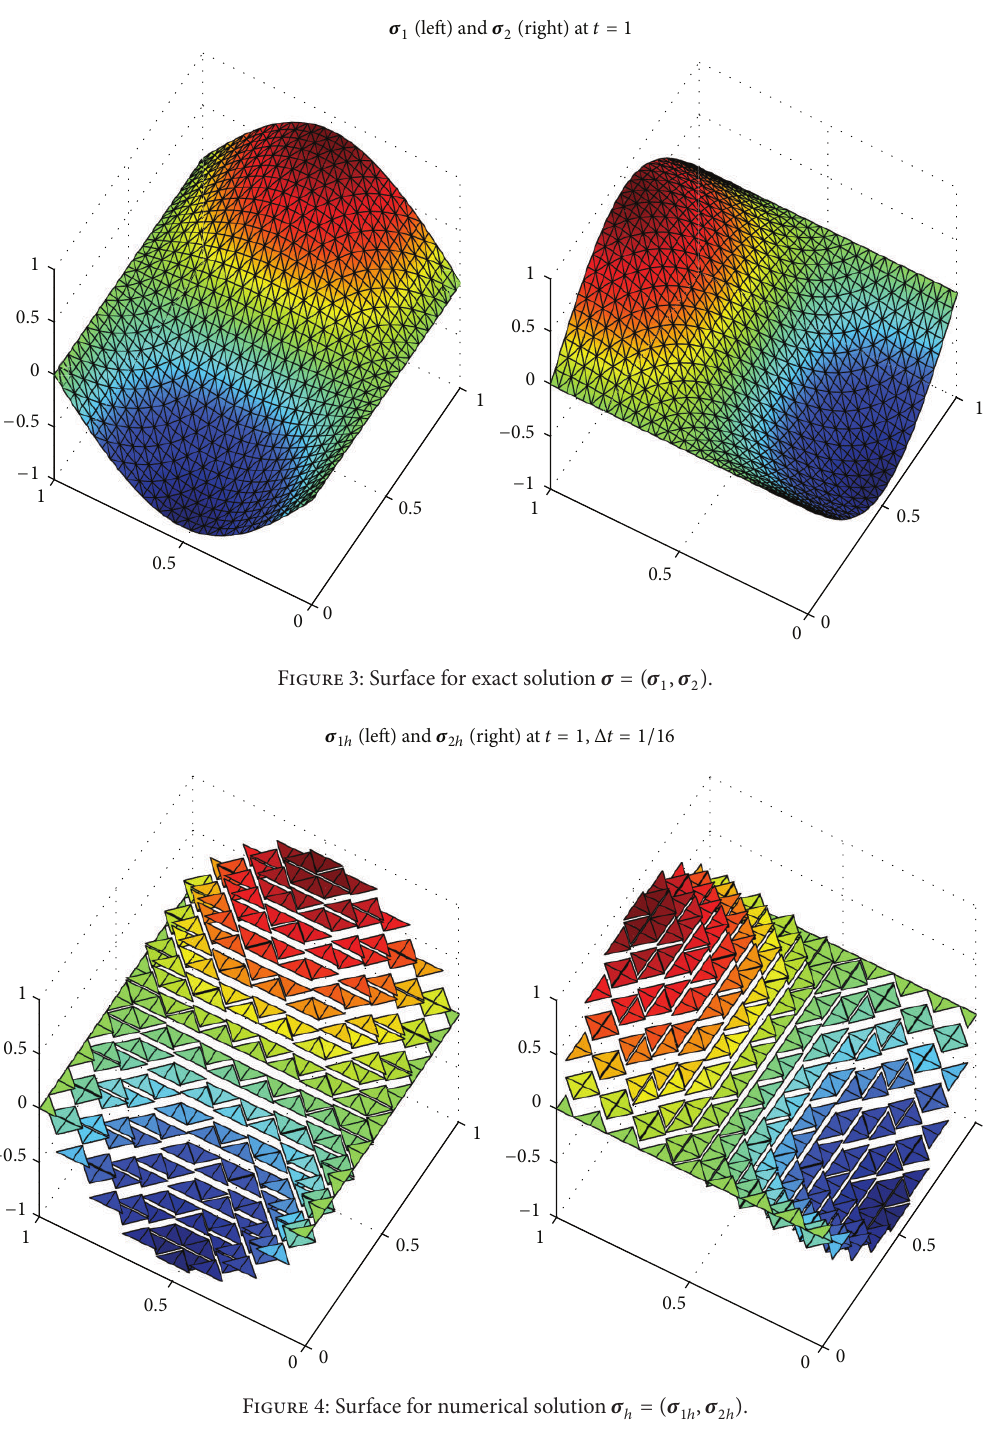
Figure 4: Surface for numerical solution 𝜎 ℎ = ( 𝜎 1ℎ , 𝜎 2ℎ )